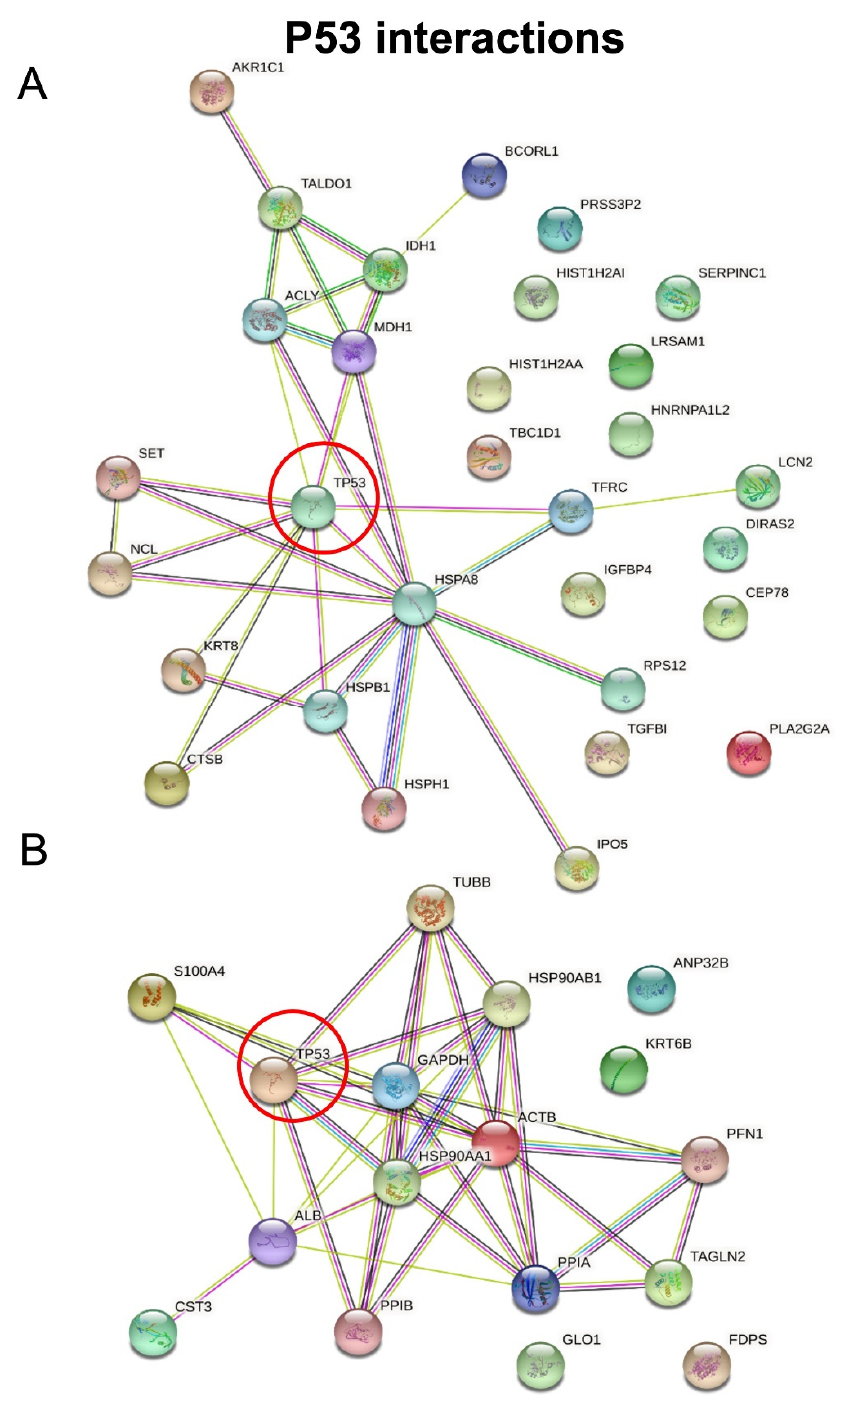
Figure 7. STRING analysis. Protein–protein interactions among modulated proteins. p53 was manually added to identify potentially related connections. The network of hypersecreted proteins is reported in ( A ) while the network of hyposecreted proteins is reported in ( B ). Finally, the diseases and functions analysis performed through the IPA software highlighted the involvement of proteins associated with leukocytes movement (HSPB1, PPIB, ACTB, HS90B, ALB and S10A4), carcinoma (CATB, ALB, CYTC and SAA4) and advanced malignant tumor (CATB, BGH3, ACTB, CYTC and SAA4) disease classes (Table 2).